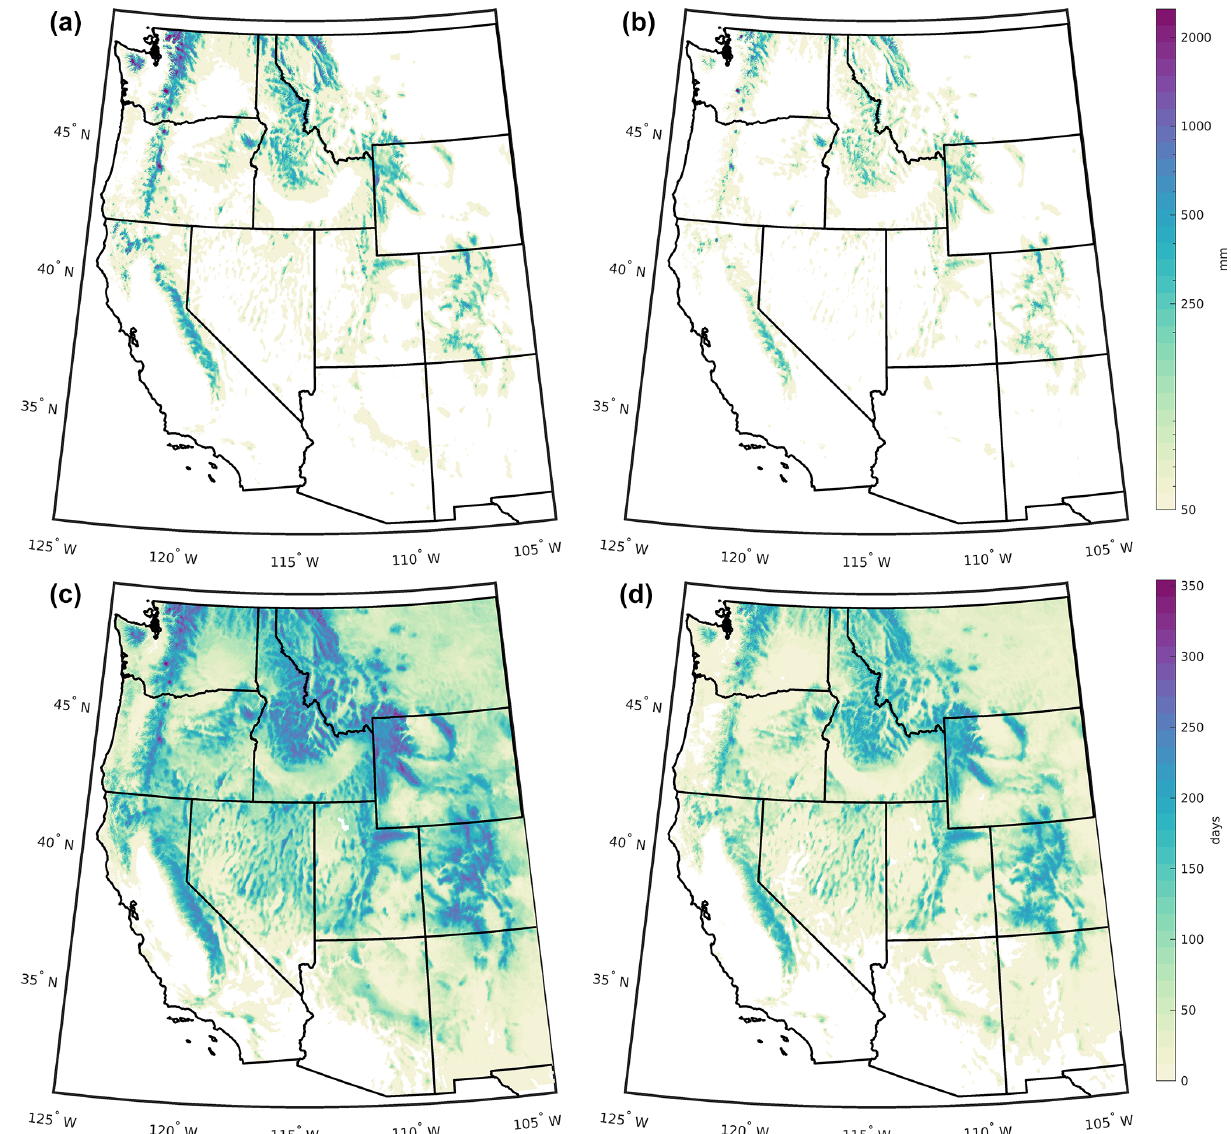
Figure 5. (a) Historical and (b) future maxswe (mm), (c) historical and (d) future snow duration (days). Historical values are averages over the period 2000–2013. Future values represent averages during the period 2071–2100 under RCP 8.5. In (a) and (b) , white land areas denote areas that had less than 50mm maxswe. In (c) and (d) , white land areas denote areas where snow duration was 0. Note the nonlinear color scale in panels (a) and (b)